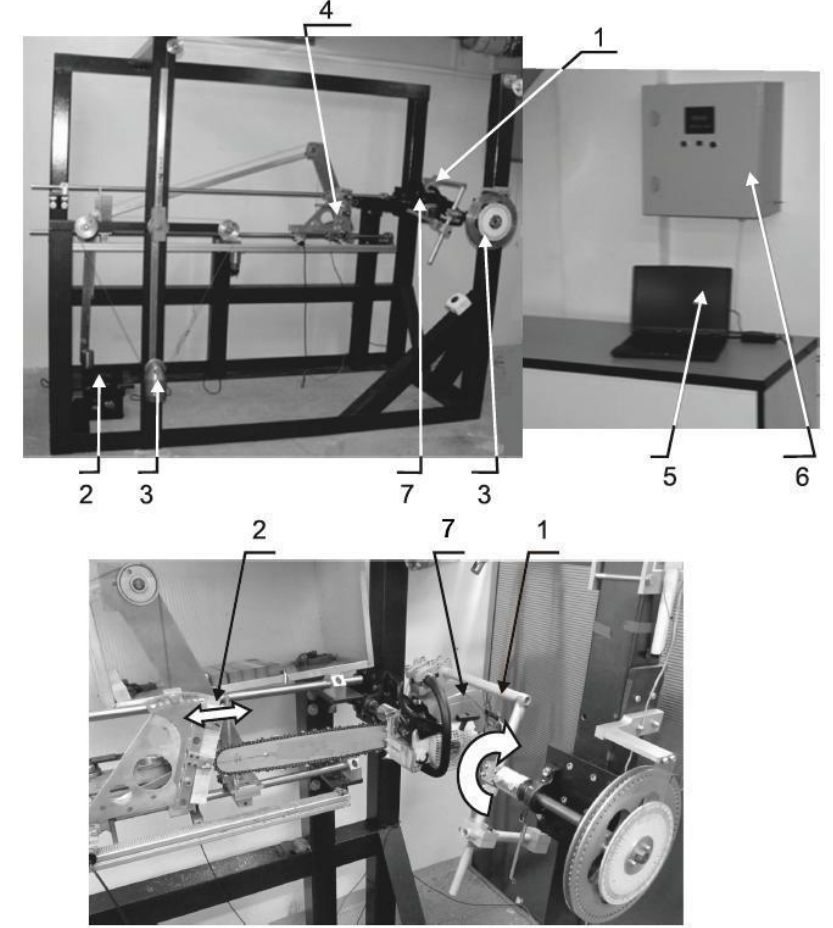
Figure 4. Basic stand for kickback testing; principle of the study of chainsaw kickback (horizontal and rotary movement energy): 1: rotary cradle (with chainsaw); 2: carriage-restraining weight; 3: cradle-restraining weights; 4: wood kickback test sample fixed in mobile carriage moving horizontal to guide bar tip; 5: control panel; 6: registering device; 7: chainsaw.